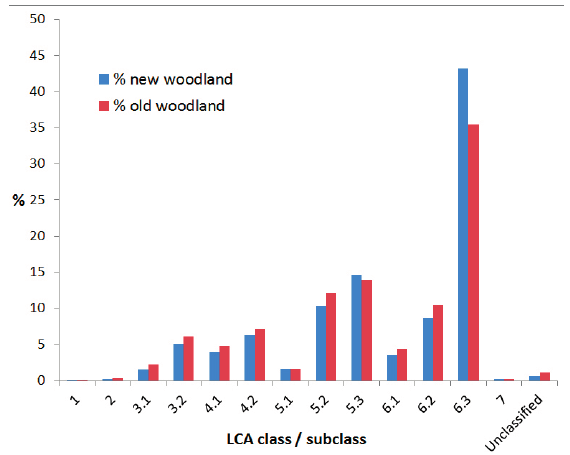
Figure 2. Proportion of new and existing woodland planted in each land capability class or